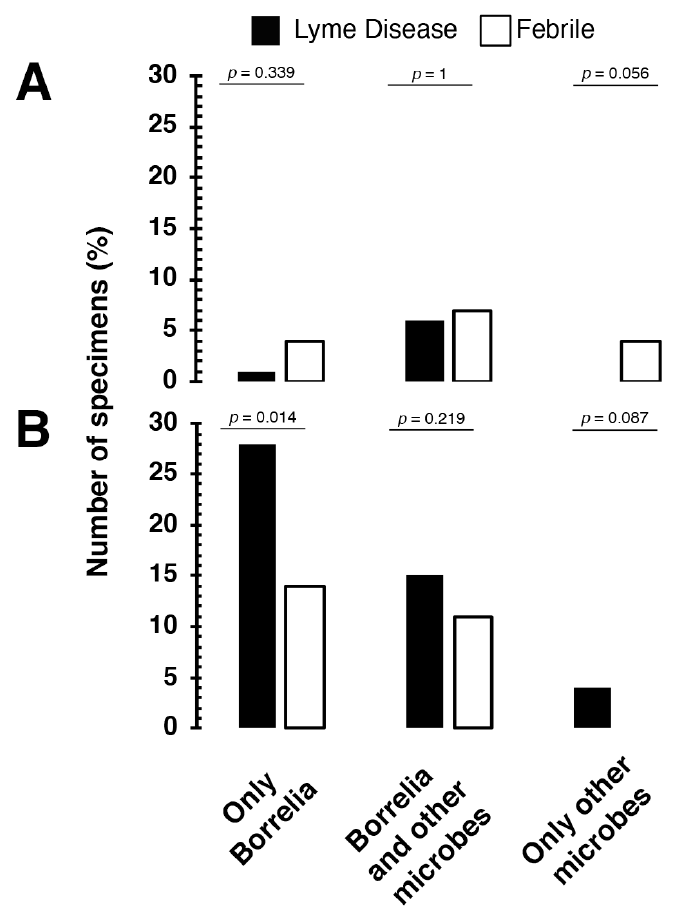
Figure 3. Lyme disease and febrile patients produce ( A ) IgM and ( B ) IgG immune responses to Borrelia and multiple coinfections and opportunistic microbes related to tick-borne diseases. Other microbes refer to Babesia microti , Bartonella henselae , Ehrlichia chaffeensis , Rickettsia akari , Coxsackievirus, Epstein–Barr virus, Human parvovirus B19, Mycoplasma fermentans , and Mycoplasma pneumoniae in the index test. The p -value originates from the Fisher’s exact test that was used to assess the statistical differences in IgM or IgG immune responses between Lyme disease (LD) (positive and negative) and febrile patient groups. The two-tailed p -values for the Fisher’s exact test were calculated using GraphPad (https://www.graphpad.com/quickcalcs/contingency1/ (accessed on 28 May 2019)). The Fisher’s exact test results with p -values < 0.05 were considered statistically associated or